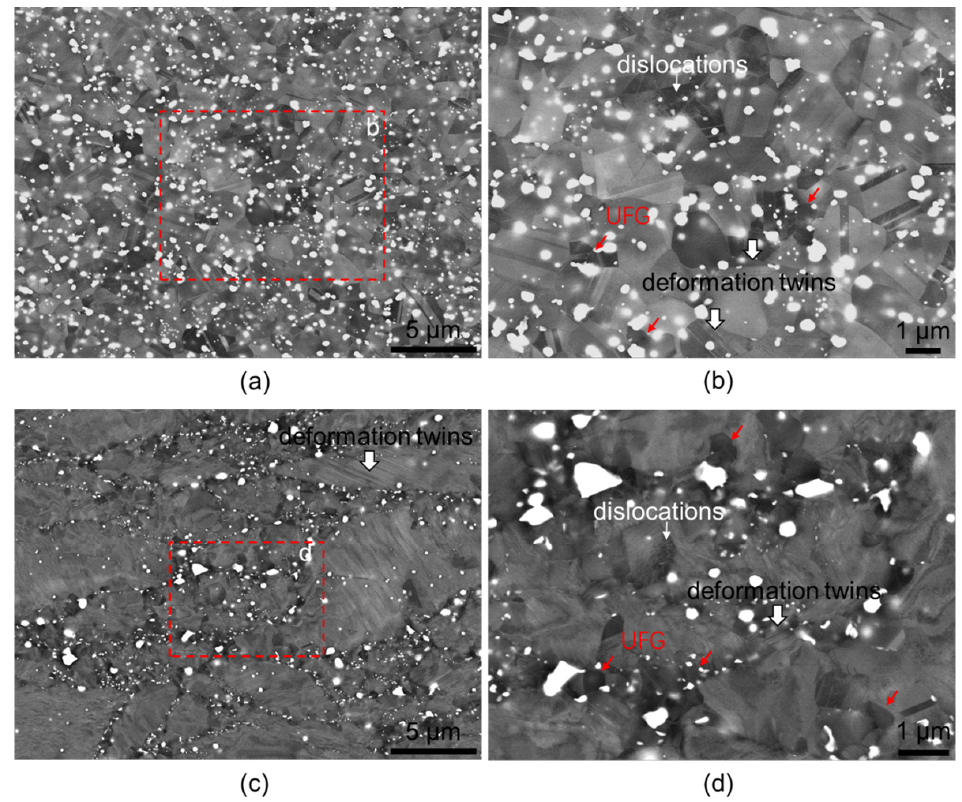
Figure 6. ECC images showing the substructures of the deformed samples: ( a , b ) FG/CG-1 and ( c , d ) FG/CG-2.